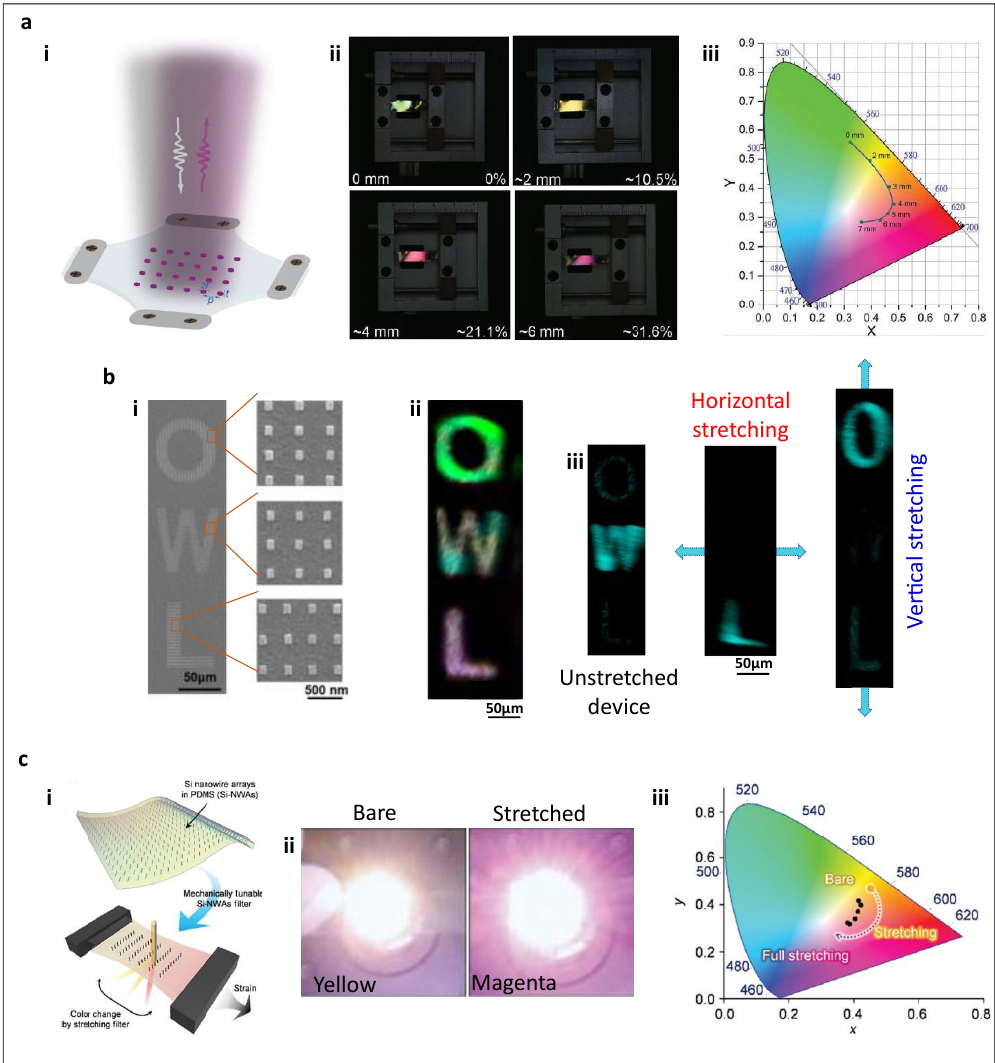
Figure 7. Mechanical tuning of structural colors. ( ai ) Schematic of a dynamic color tuning metasurface based on a PDMS substrate. ( aii ) Photographs of structural colors under different stretched lengths. ( aiii ) CIE chromaticity diagram of measured reflective spectra of the metasurface under different stretched lengths. ( bi ) SEM images of metasurface with as-fabricated patterns (O,W,L). ( bii ) CCD images of the as-fabricated patterns under white illumination. ( biii ) Dynamic image switching between different patterns under mechanical stretching. ( ci ) Schematic of a tunable nanowire color filter based on PDMS. ( cii ) Color-filtering properties of the metasurface under white illumination in the bare state and stretched state. ( ciii ) Chromaticity diagram of structural colors of the bare and stretched metasurface. ( a ) Reprinted with permission from ref. [141]. Copyright (2017) Wiley & Sons, Inc. ( b ) Reprinted with permission from ref. [137]. Copyright (2017) American Chemical Society. ( c ) Reprinted under the Creative Commons Attribution 4.0 License (CC BY 4.0) from ref. [142].